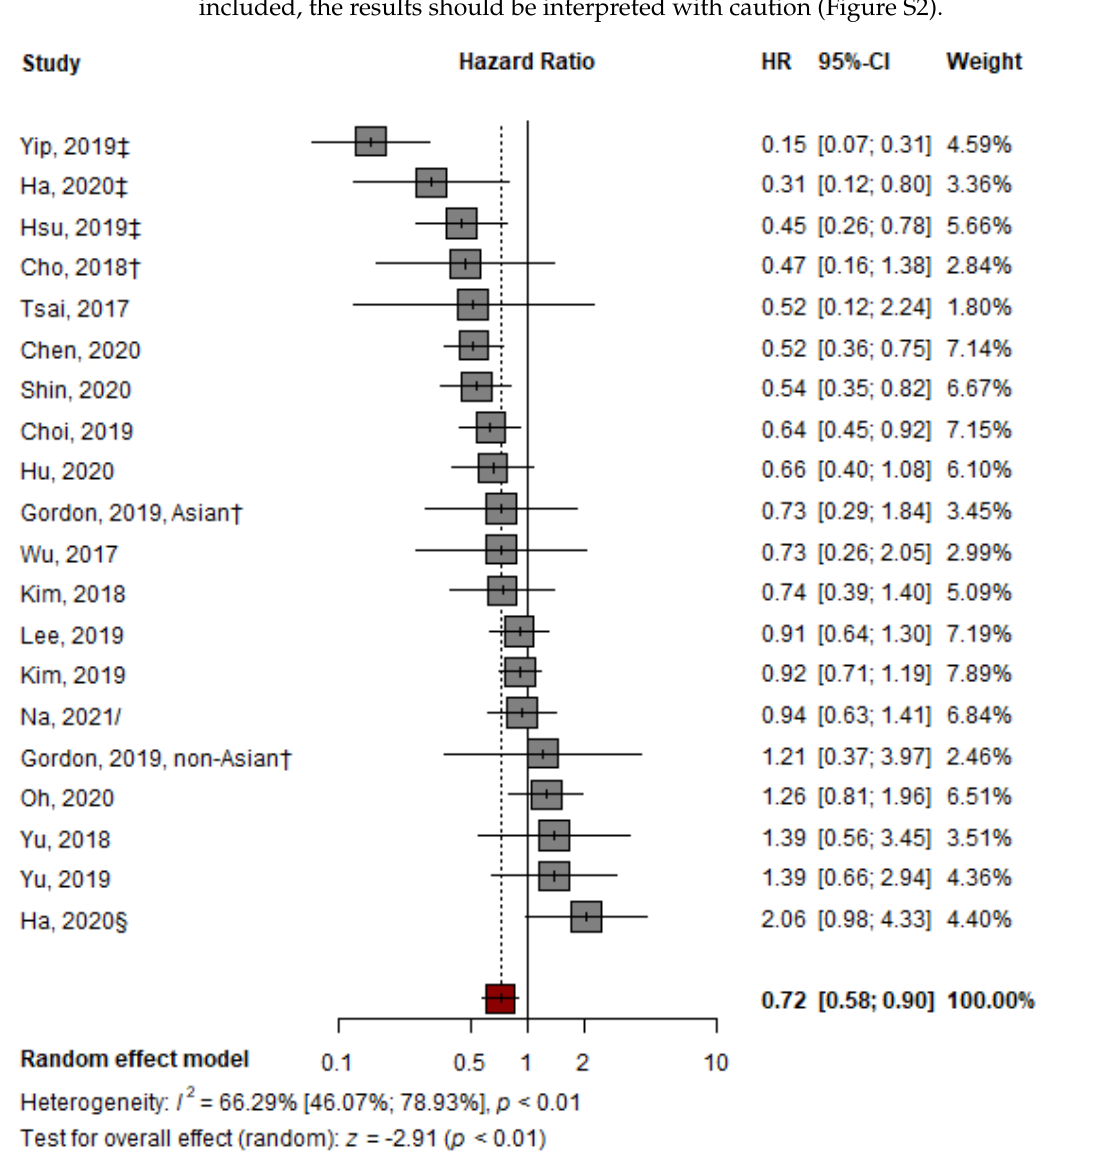
Figure 2. Pooled analysis of representative HRs presented in individual papers comparing the effectiveness of TDF vs. ETV at reducing HCC development. HR: hazard ratio; † abstract; ‡ suggest outcomes from competing risk analysis; § Ha from CHA Bundang Medical Center, CHA University;/from unadjusted cohort at the time of CVR [7,23–40].